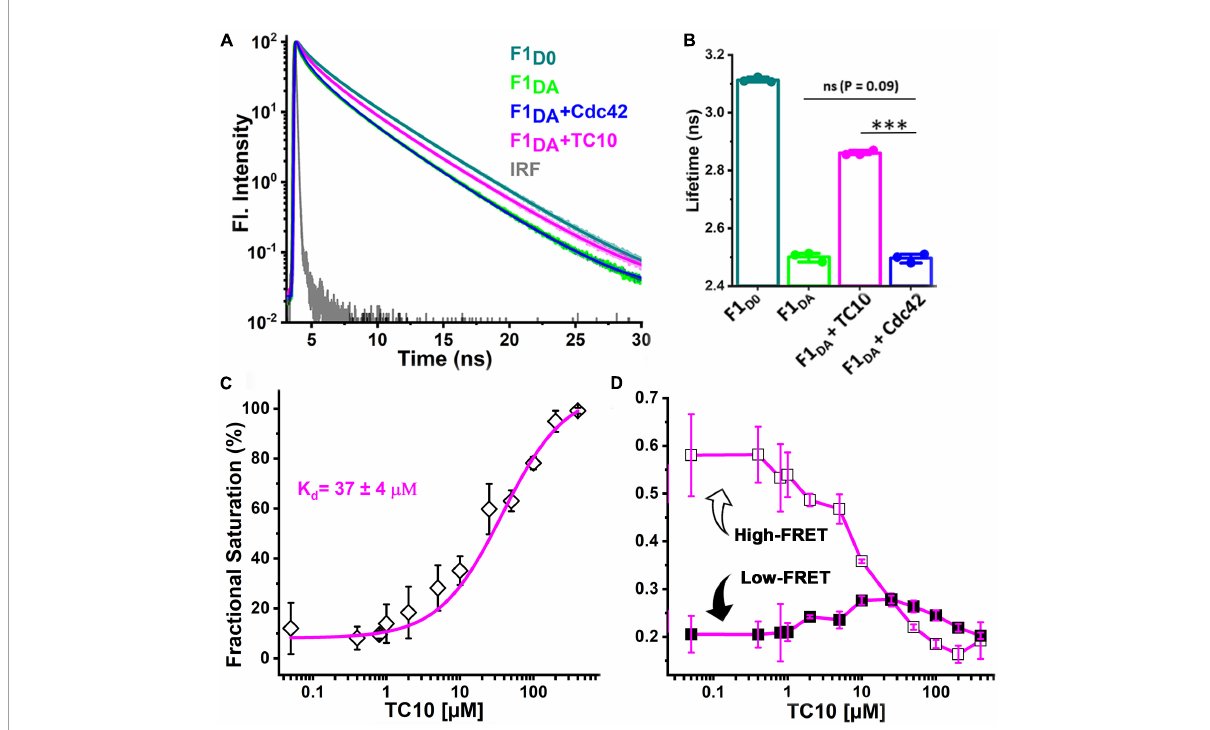
FIGURE2 TC10 and Cdc42 interaction with a CB FRET sensor. (A) Time-resolved CFP fluorescence intensities for the CB FRET sensor F1 D 0 (teal), its FlAsH-labeled counterpart F1 DA alone (green) and in the presence of a 100-fold molar excess (100 µ M) of Cdc42 (blue) and TC10 (magenta). The instrument response function (IRF) is shown in gray. F1 D 0 and F1 DA were excited ( λ ex ) at 440 nm. Emission ( λ em ) data were collected between 460 and 500 nm and fitted with Equation 1 to obtain the average fluorescence lifetime (cid:104) τ (cid:105) for the respective samples. For easier comparison data were scaled to a maximum of 10 2 . (B) Bar plot showing species-weighted (cid:104) τ (cid:105) of CFP in F1 D 0 (teal), F1 DA , alone (green) and in the presence of a 100-fold molar excess of TC10 (magenta) and Cdc42 (blue). Data from three individual biological replicates ( n = 3) are presented as mean values ± SD. ∗∗∗ P < 0.001; ns, statistically not significant. (C) F1 DA binding affinity plot of TC10. Binding affinity was determined by first converting (cid:104) τ (cid:105) into the fractional saturation using Equation 4 and the data were further fitted with Equation 5. The F1